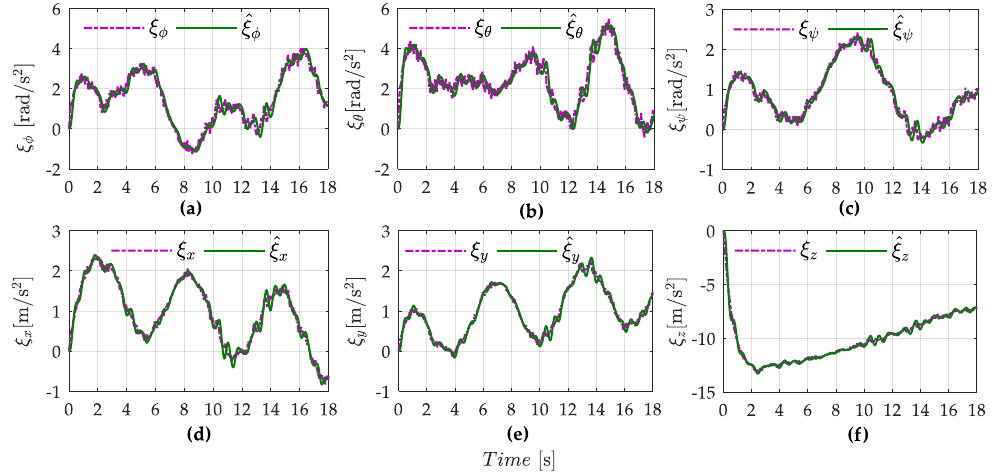
Figure 4. Disturbance estimation in attitude dynamic ( a – c ) and position dynamic ( d – f ) of the proposed ESDO.